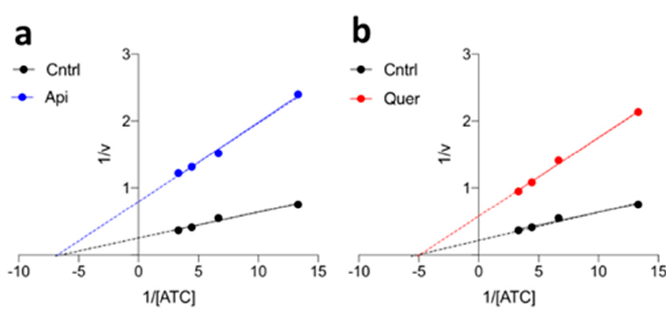
Figure 9. Lineweaver–Buck plots. ( a ) Apigenin. ( b ) Quercetin.